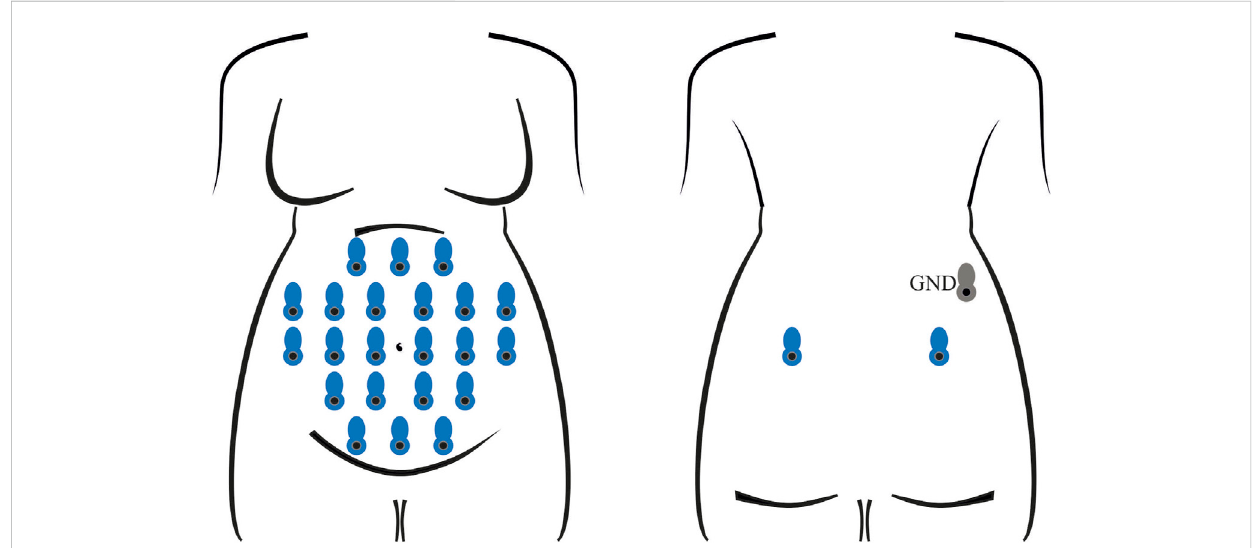
FIGURE 1 Electrode positioning for the recording of all abdominal signals involved in training and testing the classi fi cation model. In each session, 24 unipolar channels were acquired with an average-reference ampli fi er, exploiting 22 measuring electrodes on the abdomen and two on the back (in blue) of the pregnant volunteer, along with a ground electrode (in grey), also on the back.